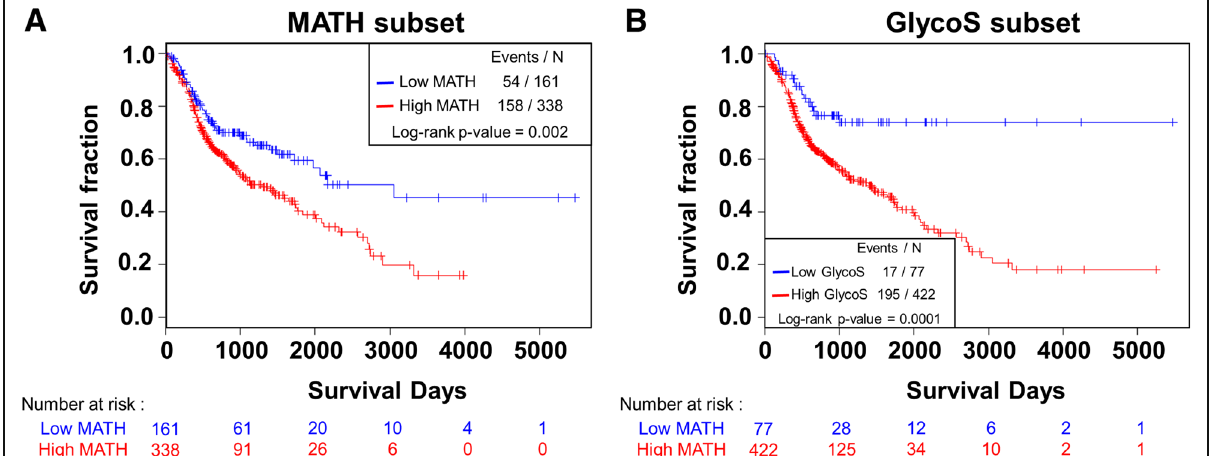
Fig. 7 Prognostic value of MATH and GlycoS. Kaplan-Meier curves of each group divided with adjusted cutoff value of genetic signatures. Survival analysis and log-rank test were performed to compare each group. a Low MATH and high MATH subsets for 499 patients. Red, high MATH (MATH > 37.17); blue, low MATH (MATH < 37.17). b Same analysis as ( a ) comparing low GlycoS and high GlycoS subsets. Red, high GlycoS (GlycoS > 0.80); blue, low GlycoS (GlycoS < 0.80). Of note, low and high MATH and GlycoS groups are divided according to the optimized cut-offs obtained by cut-off finder (http://molpath.charite.de/cutoff/index.jsp)